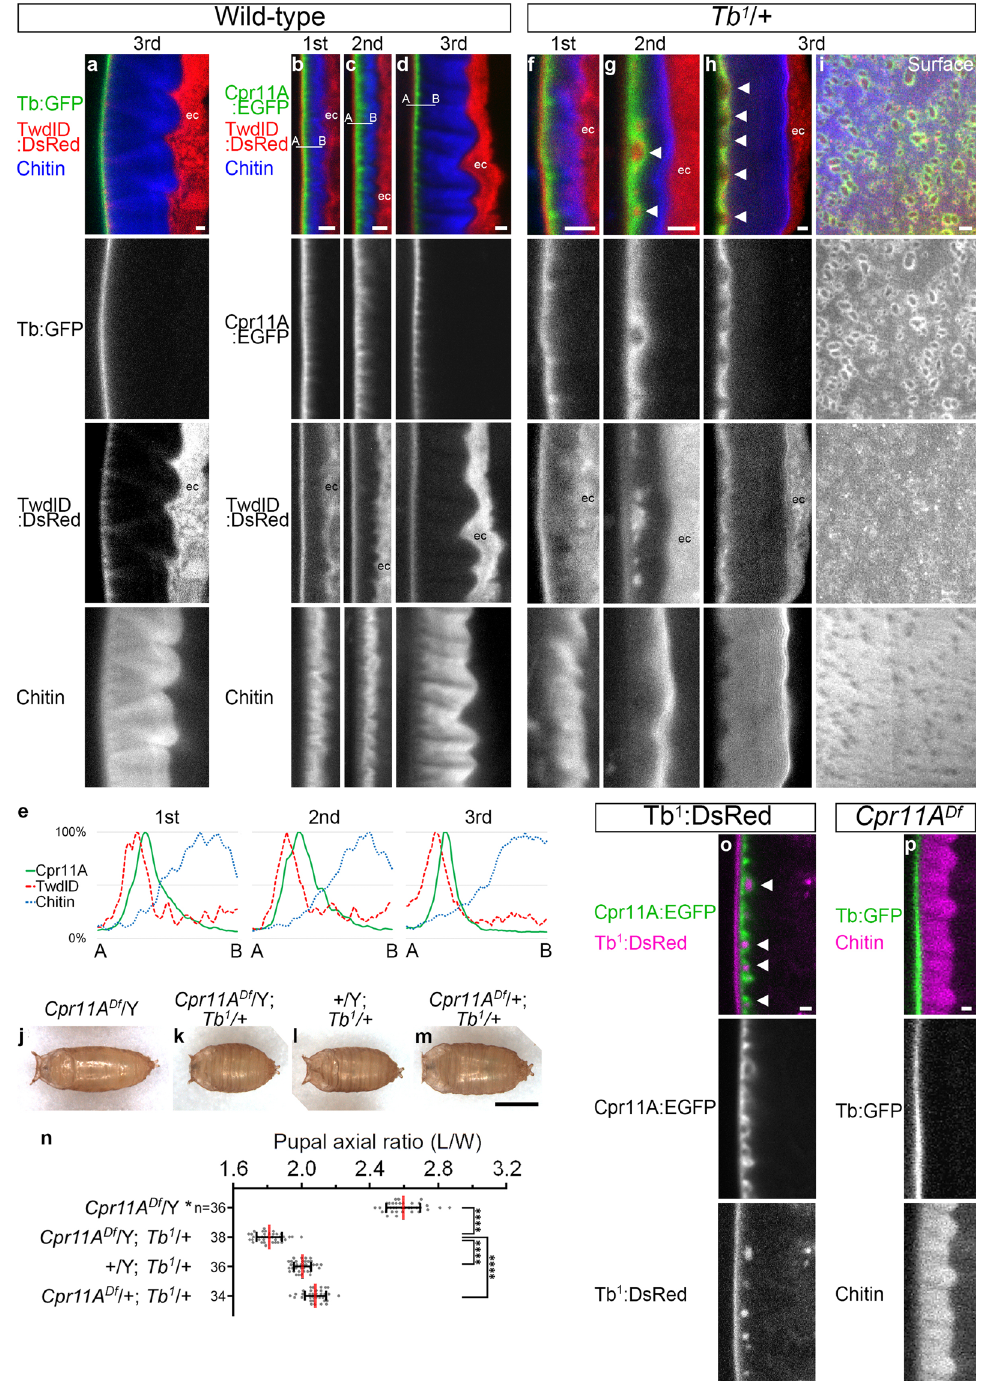
Fig. 5 Interaction of Cpr11A with Twdl proteins. a Localization of Tb:GFP, TwdlD:DsRed and chitin in a cross-section of a wild-type third instar larval cuticle. b - d Localization of Cpr11A:EGFP, TwdlD:DsRed and chitin in cross-sections of wild-type fi rst ( b ), second ( c ) and third ( d ) instar larvae. e Pro fi les of Cpr11A:EGFP, TwdlD:DsRed and chitin signal intensities along the apical (A)-to-basal (B) lines shown in b – d , normalized by maximum signal intensity of each channel. f – h Cpr11A:EGFP, TwdlD:DsRed and chitin localization in cross-sections of Tb 1 / + fi rst ( f ), second ( g ) and third ( h ) instar larvae. i Cpr11A: EGFP, TwdlD:DsRed and chitin localization viewed from the surface of a Tb 1 / + third instar larva. Anterior is to the left. Bar, 5 μ m. j – m Pupae of the indicated genotypes, viewed from the dorsal side. Anterior is to the left. Bar, 1 mm. n Mean ± S.D. of pupal axial ratios (L/W) of individual genotypes. The same data for Cpr11A Df /Y used in Fig. 1j are used here for comparison. n, the number of pupae measured for each genotype. Signi fi cance was assessed using one-way ANOVA ( p < 0.0001) and Tukey ’ s multiple comparisons test. **** p < 0.0001. o Cpr11A:EGFP and Tb 1 :DsRed localization in a cross-section of a Cpr11A: EGFP / 2xTb 1 :DsRed third instar larva. p Tb:GFP and chitin localization in a cross-section of a Cpr11A Df /Y third instar larva. In a – d , f – h and o – p , cross-sections are perpendicular to the anteroposterior axis, and apical (external) is to the left. Bars, 2 μ m. Arrowheads, bubble-like basal bulges of Cpr11A:EGFP; ec, TwdlD:DsRed signals observed within epidermal cells.